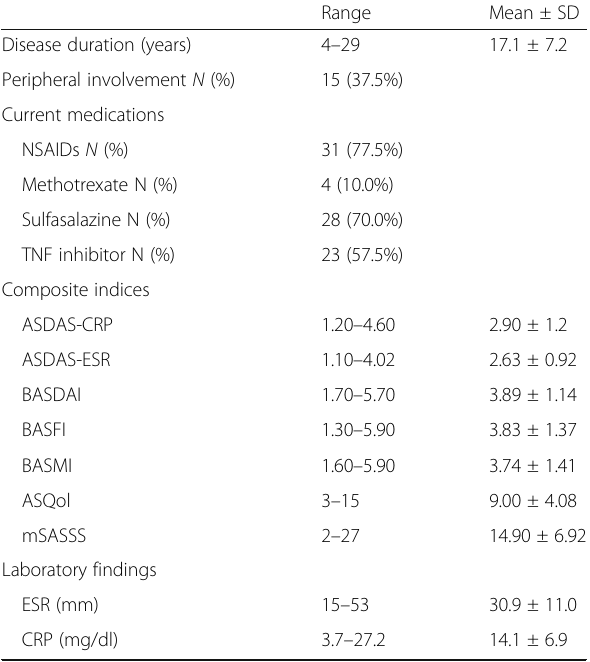
Table 1 Clinical features, current medication, composite indices, and laboratory findings of the AS